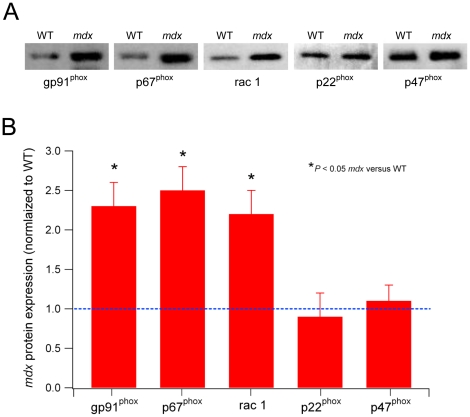
NADPH oxidase subunits are increased in 18–19 day old (pre-necrotic) mdx mice.A. Representative western blots of all NADPH oxidase subunits from TA muscles of 18–19 day old WT and mdx mice. B. Pooled results from densitometry for the subunits showing mdx values normalized to WT (represented by the blue dotted line). The proteins gp91phox, p67phox and rac1 were all significantly increased in mdx muscle compared to WT, whereas p22phox and p47phox were not different (n = 4 samples for each group).